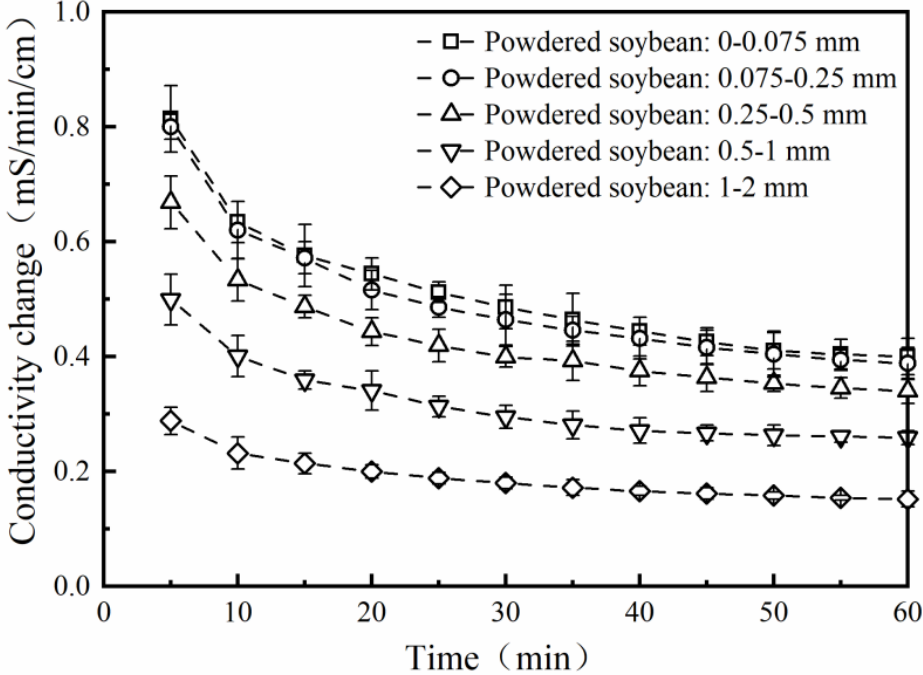
Figure 1. Change of electrical conductivity with time after mixing the soybeans crude urease and urea solution (1 M).